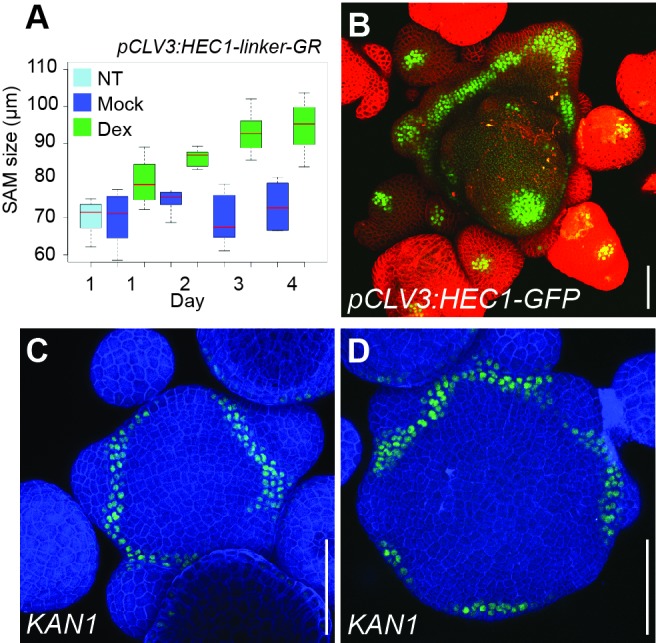
SAM behavior after promoting of HEC function at the CZ.(A) Development of individual pCLV3:HEC1-linker-GR SAM size after mock or dex treatment (n > 6 per condition). (B) Representative view of pCLV3:HEC1-linker-GFP SAM 30 DAG. (C–D) Representative views of pCLV3:HEC1-linker-GR SAM expressing pKAN1:GFP-KAN1 after mock (C) or dex (D) treatment (n = 2) Scale bar: 50 µm.